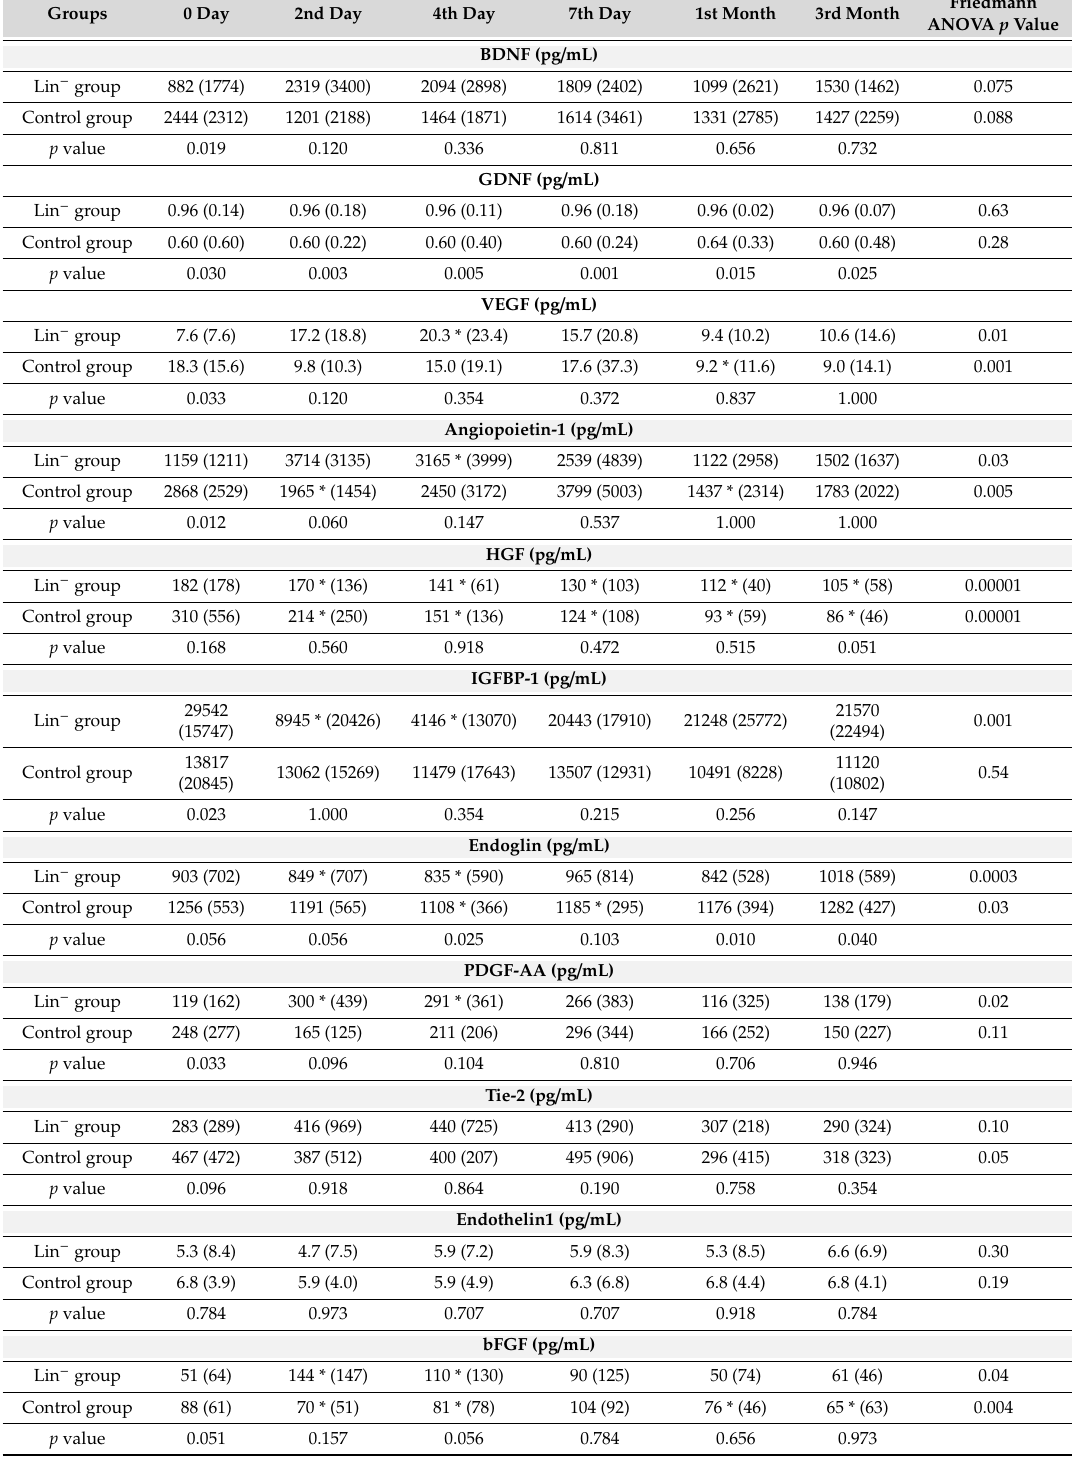
Table 4. The plasma concentrations of brain-derived neurotrophic factor (BDNF), glial-derived neurotrophic factor (GDNF), vascular endothelial growth factor (VEGF), angiopoietin-1, hepatocyte growth factor (HGF), insulin-like growth factor binding-protein 1 (IGFBP-1), endoglin, platelet-derived growth factor-aa (PDGF-AA), angiopoietin-1 receptor (Tie-2), endothelin-1, and bFGF in the Lin − group and in the control group (day 0, 2, 4, and 7 and in month 1 and